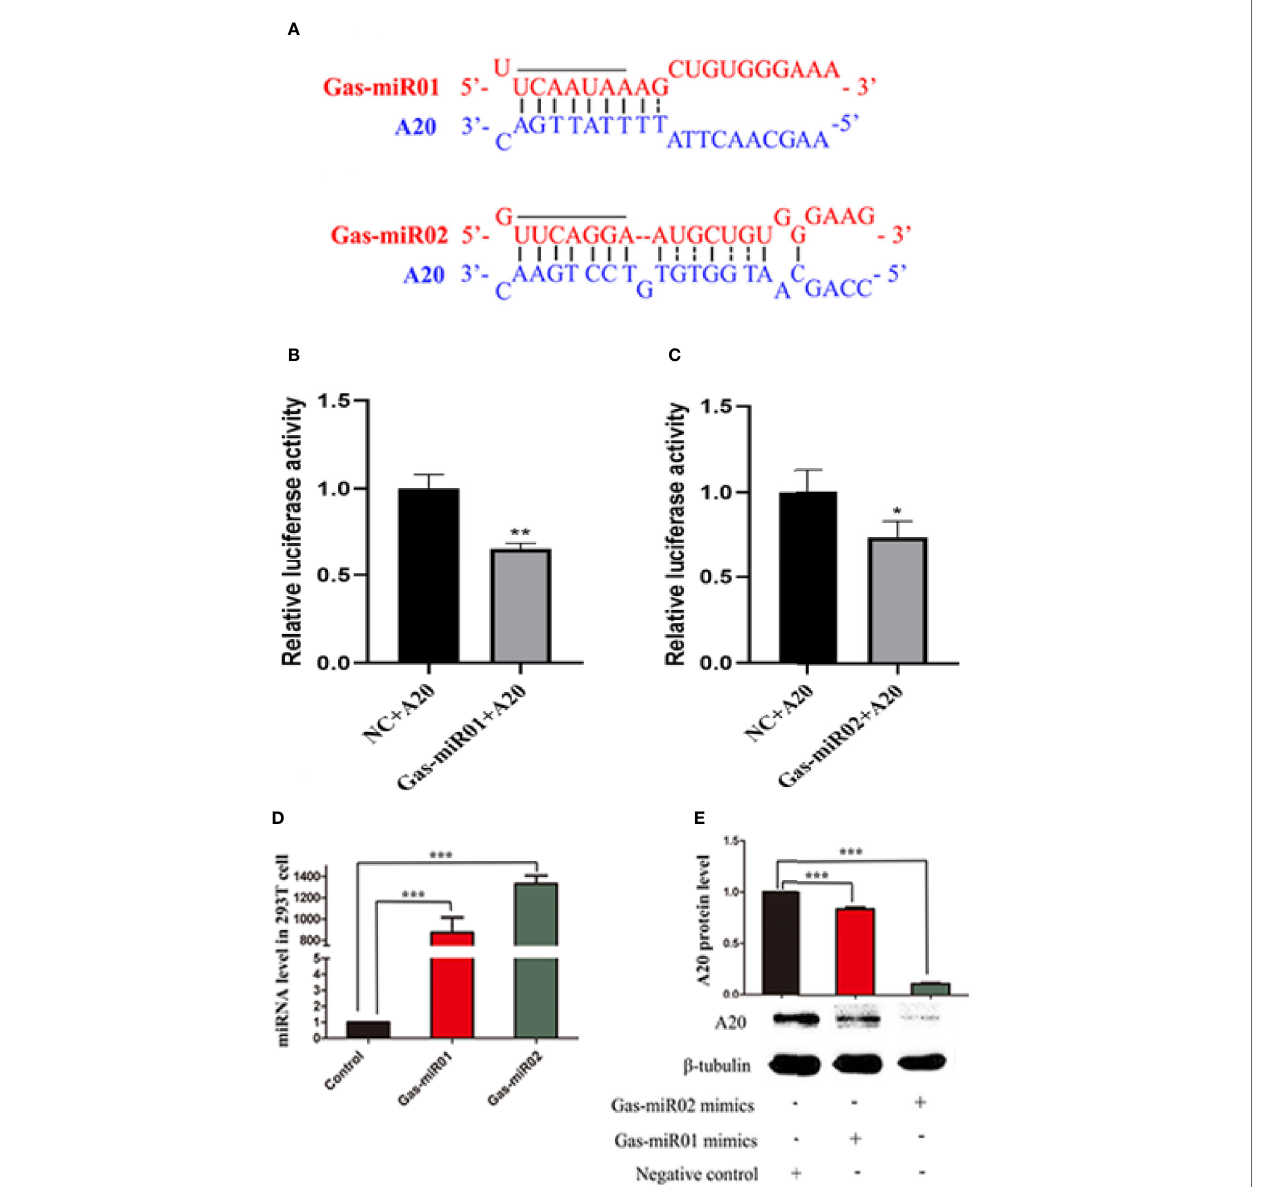
FIGURE 5 | The down-regulation of A20 by Gas-miR01 and Gas-miR02. (A) Matching between Gas-miR01, Gas-miR02 and their target sites in A20 gene. (B) The relative luciferase activity down-regulated by Gas-miR01. (C) The relative luciferase activity down-regulated by Gas-miR02. (D) Levels of Gas-miR01 and Gas-miR02 in 293T cells after transfected with corresponding mimics. (E) The expression level of A20 protein after transfected with Gas-miR01 and Gas-miR02 mimics. * p < 0.05; ** p < 0.01; *** p < 0.001. Values are the mean ±